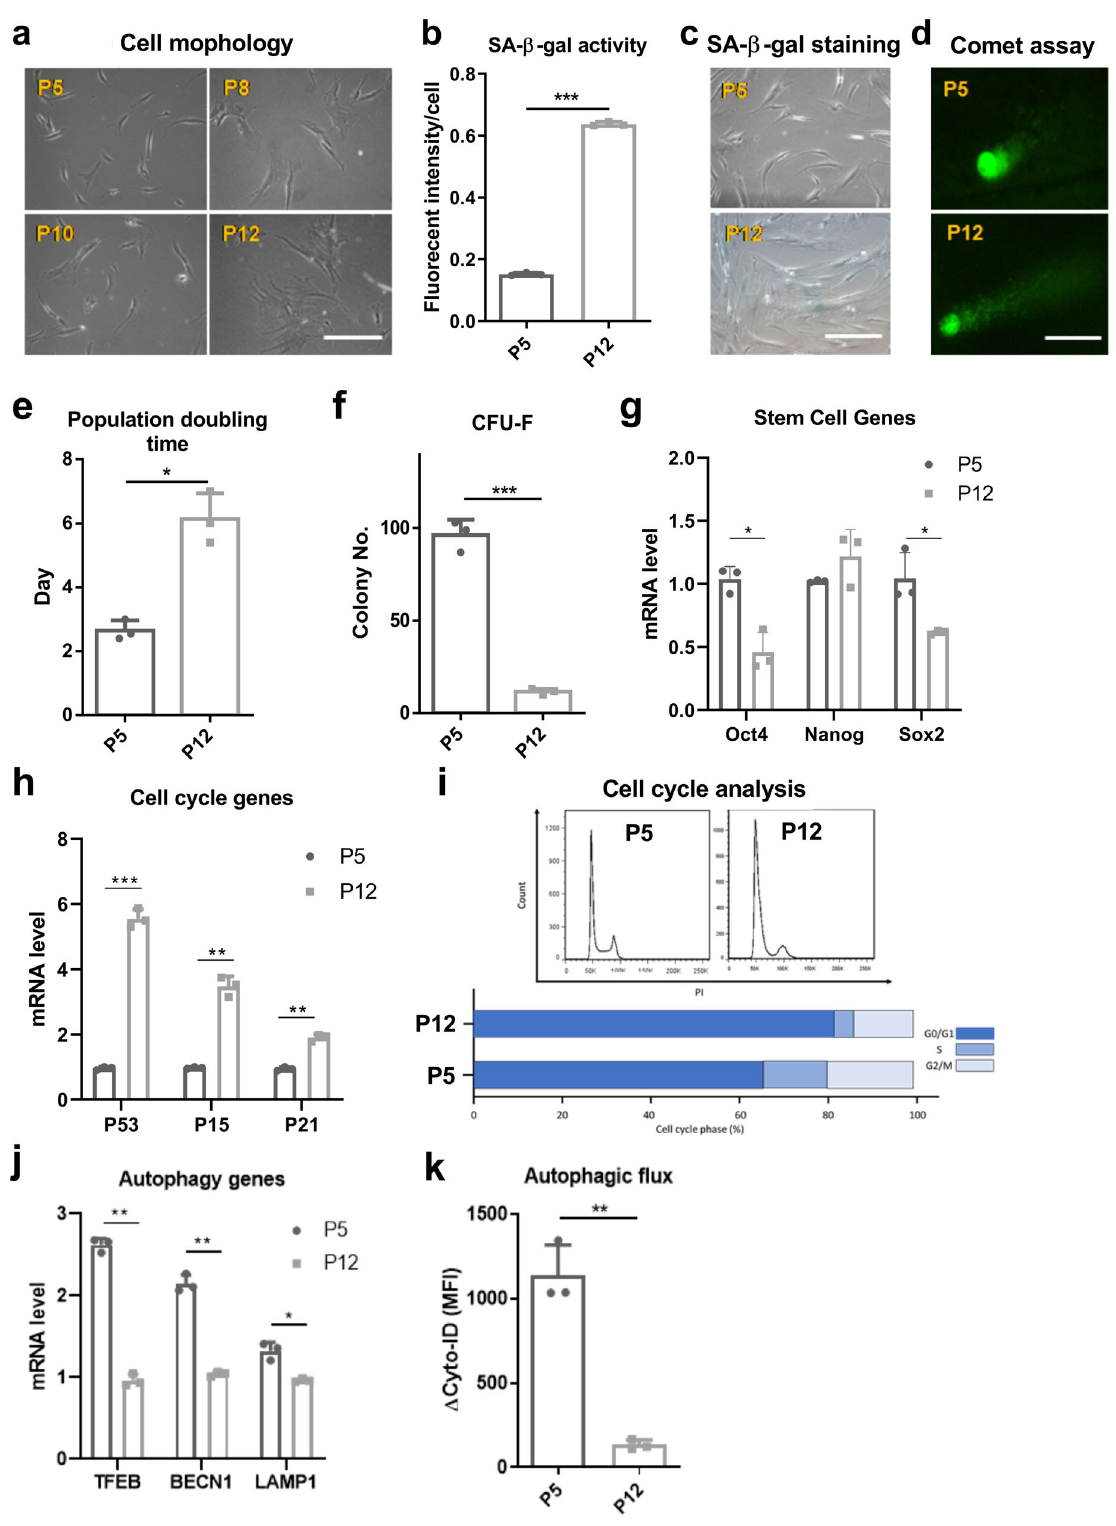
Fig. 1 In vitro culture expansion of human mesenchymal stem cells (hMSCs) results in cellular senescence and breakdown of cellular homeostasis. a Alteration of hMSC morphology during culture expansion. b SA- β -gal activity and c SA- β -gal staining in hMSCs at early passage and late passage. d Comet assay demonstrates DNA damage of hMSCs during culture expansion. e Population doubling (PD) time increased for long-term cultured hMSCs. f Colony- forming unit- fi broblast (CFU-F) ability decreased during culture expansion of hMSCs. g mRNA levels of stem cell genes and h mRNA levels of cell cycle genes in hMSCs at late passage compared to cells at early passage. i Cell cycle analysis of hMSCs via fl ow cytometry. j Autophagic gene expression of hMSCs during culture expansion. k Basal autophagic fl ux was reduced in hMSCs at late passage compared to early passage. Late passage of hMSCs: passage 12 (P12), early passage of hMSCs: passage 5 (P5). Biological replicates ( n ): n = 3 for the tests. Scale bar: 100 µ m. * p <0.05; ** p < 0.01; *** p <